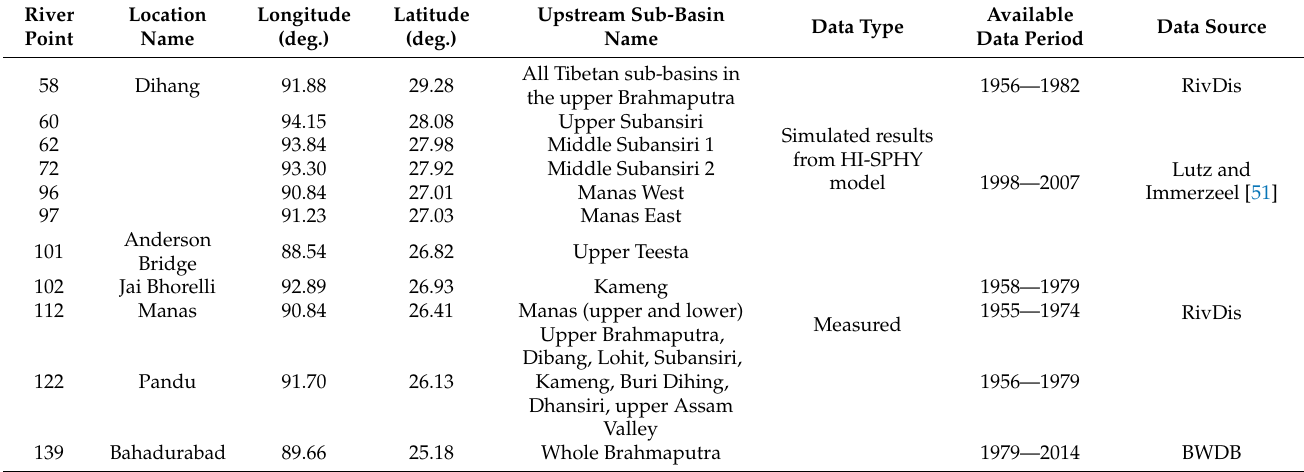
Table 2. Model comparison points and data availability for observed